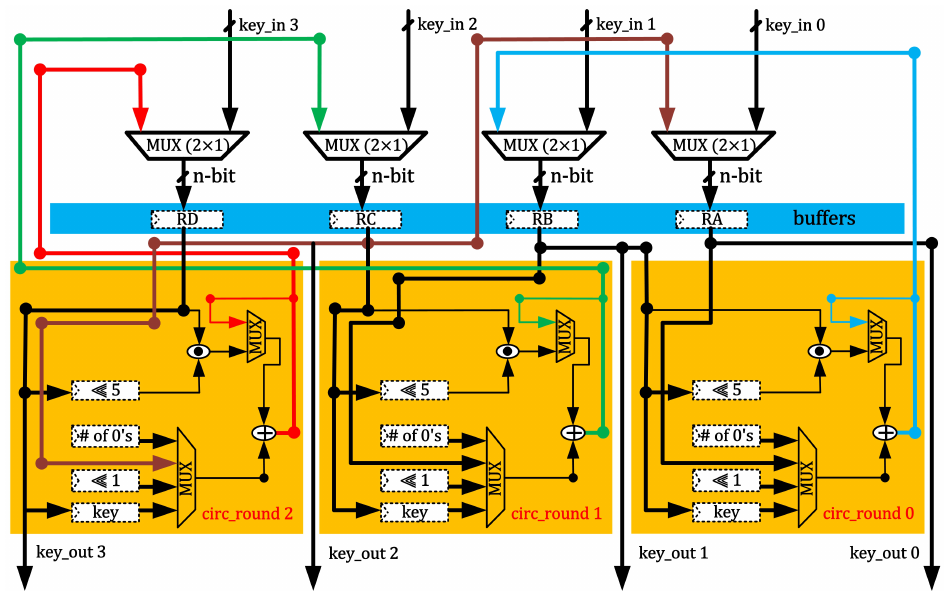
Figure 3. Proposed key expansion architecture for